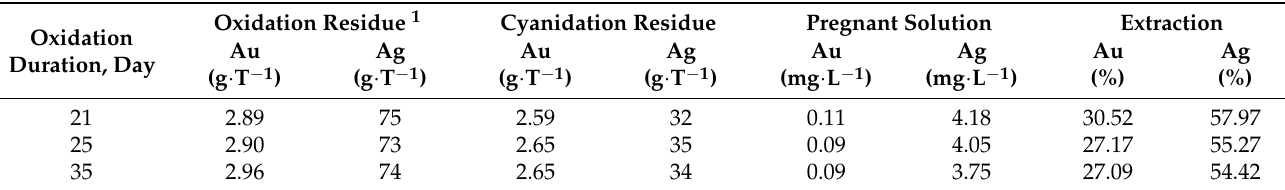
Table 4. Analyses and extraction of Au and Ag from the FeS 2 concentrate at the end of chemical–bacterial oxidation. Data show the maximum value reached after 72 to 96 h of agitation leaching using NaCN as the extractant. Oxidation Duration,